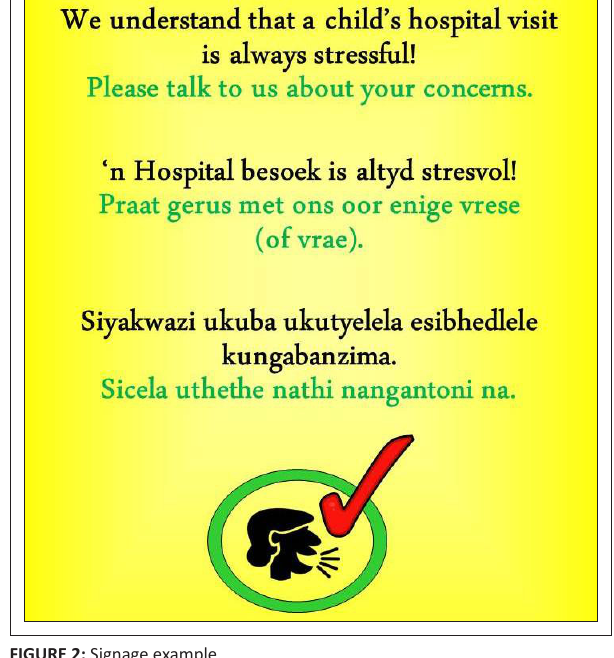
FIGURE 2: Signage